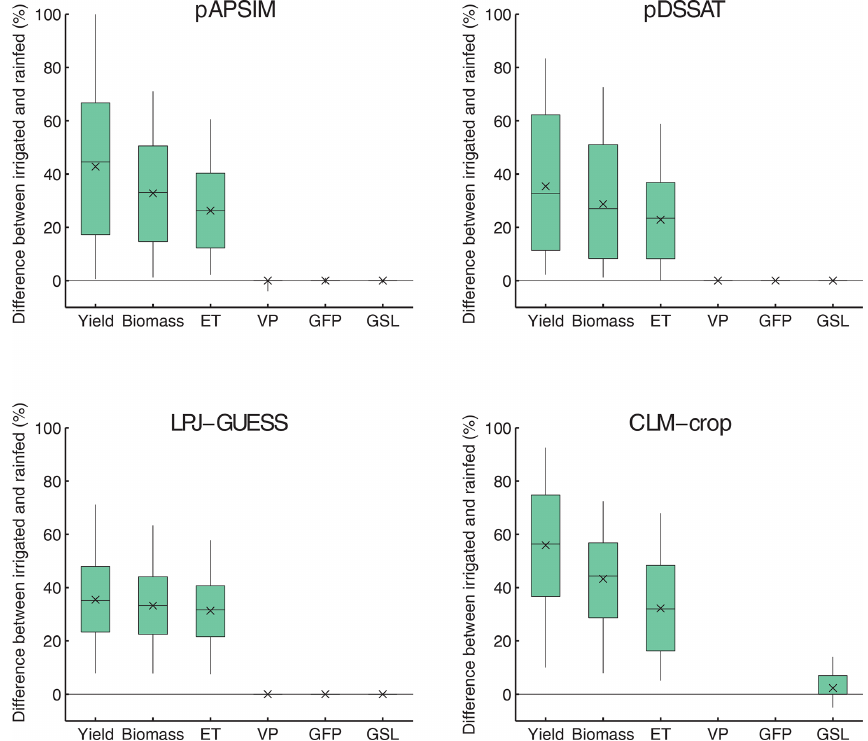
Figure 9. Box plot of crop-model-simulated yield, biomass, ET, and phenological duration (VP, GFP, and GSL) differences between irrigated and rainfed maize areas. For phenological duration, CLM-crop only reports